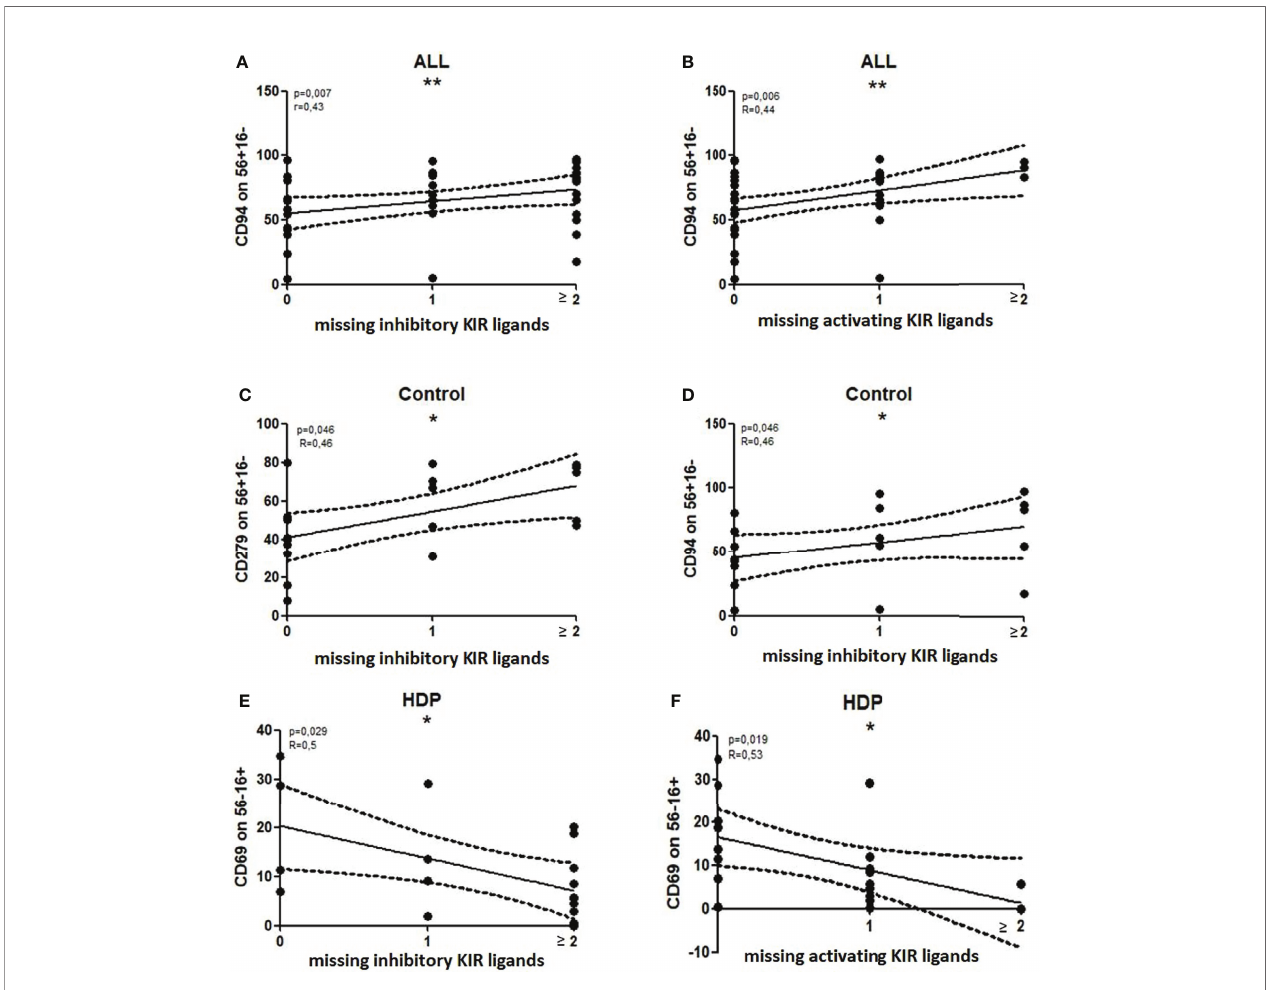
FIGURE 6 | Signi fi cant correlations between the number of missing KIR ligands (MSLs) and the percentages of NK subsets. Nonparametric Spearman correlation with 95% con fi dence interval lines, p<0.05 is considered signi fi cant. *p<0.05; **p<0.01, ns- not signi fi cant. All – all patients, Control – healthy control patients, HDP- hypertensive disorders of pregnancy